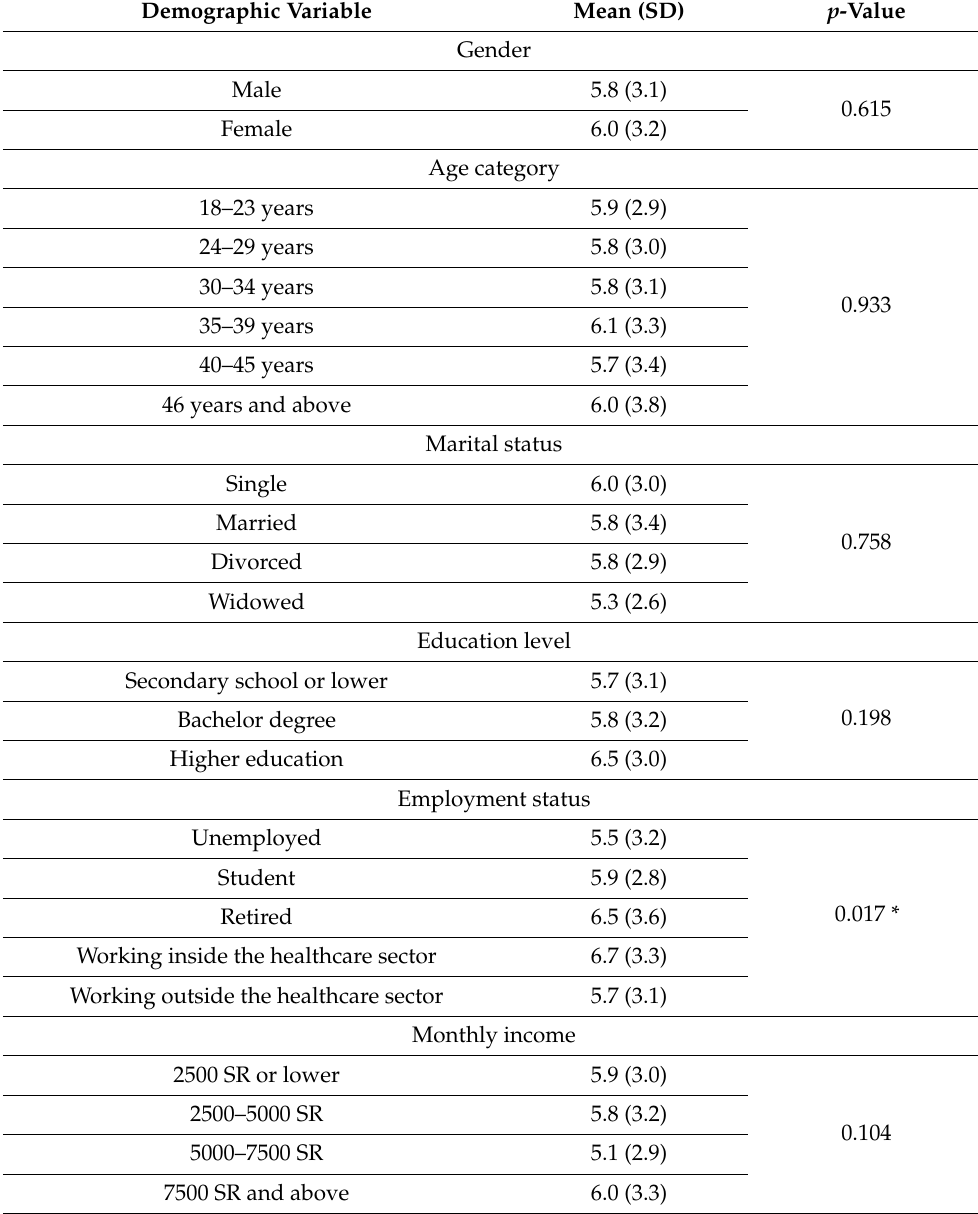
Table 2. Mean autism knowledge score stratified by demographic